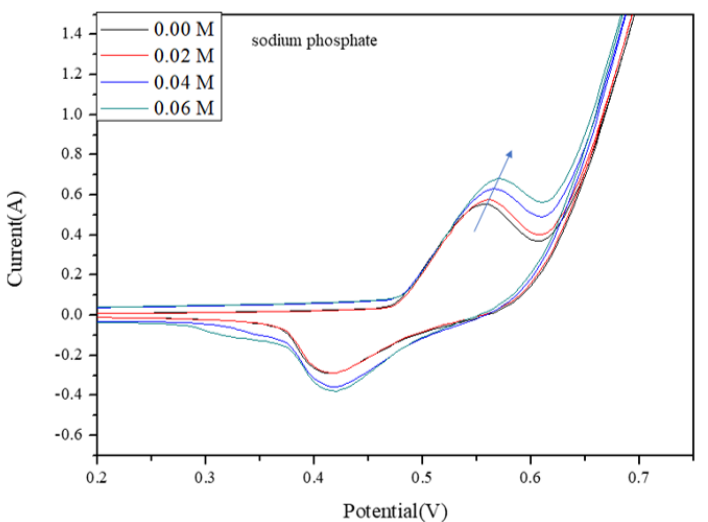
Figure 7. Cyclic voltammograms of 1.0 mM glucose by the prepared catalytic electrode (No. 4).with different sodium phosphate in 0.1M NaOH with scan rate 100 mV/min.